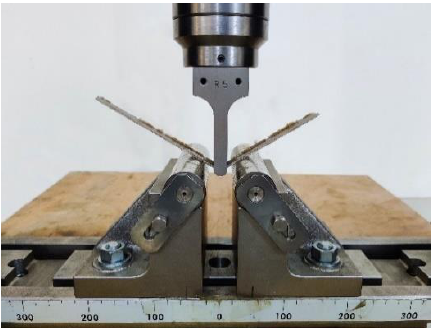
Figure 4. Flexural specimen setup in universal testing machine.